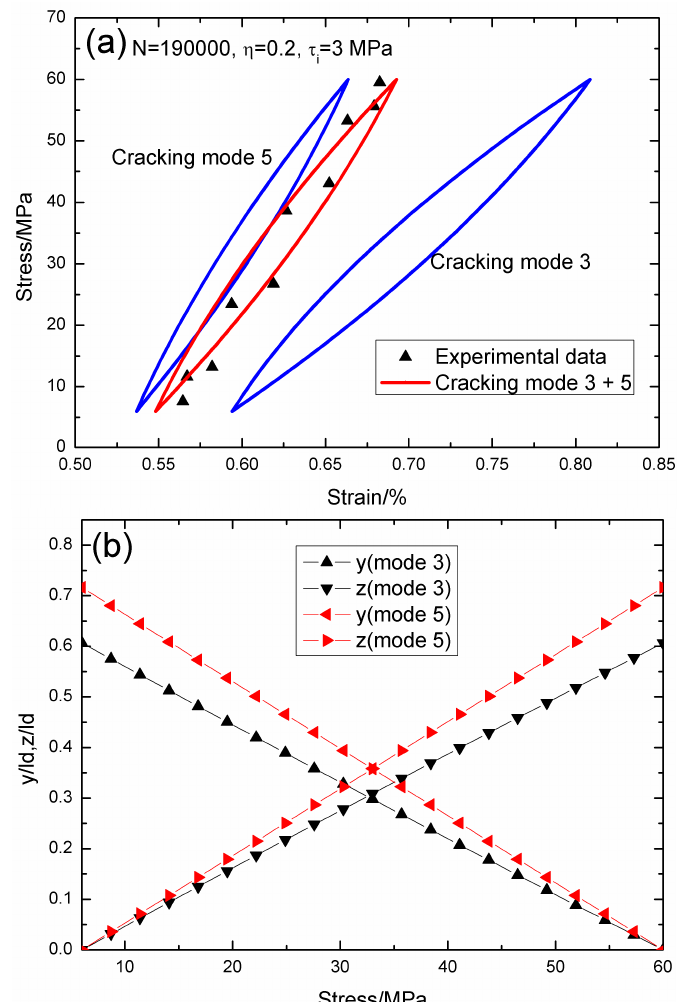
Figure 6. ( a ) The theoretical and experimental hysteresis loops; and ( b ) the interface slip lengths, i.e. , y / l d and z / l d , of matrix cracking modes 3 and 5 of 2D woven SiC/SiC composite under σ max = 60 MPa at 1000 °C in steam and a loading frequency of 1.0 Hz when N =